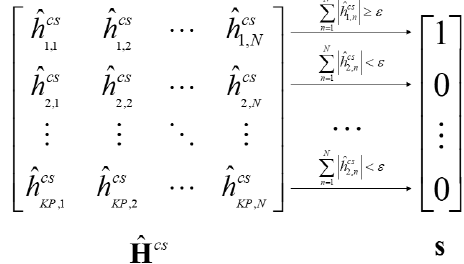
Figure 3. Relationship between ˆH cs and common support s